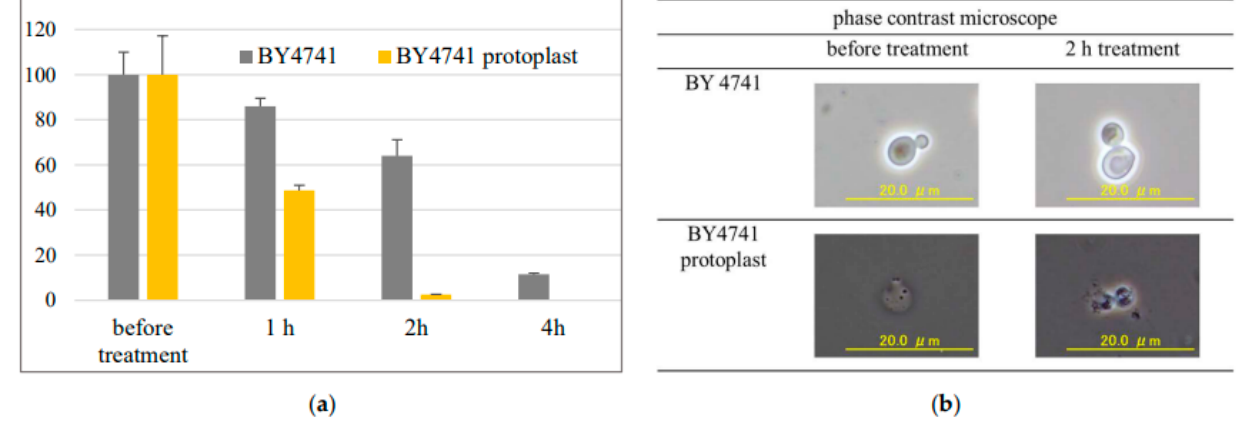
Figure 4. The sensitivity of normal cells and protoplast cells to HPCD treatment. ( a ) Survival of yeast cell rates after HPCD treatment. The percentage before treatment was set to 100%. ( b ) Visualization of yeast cells by phase-contrast microscopy.